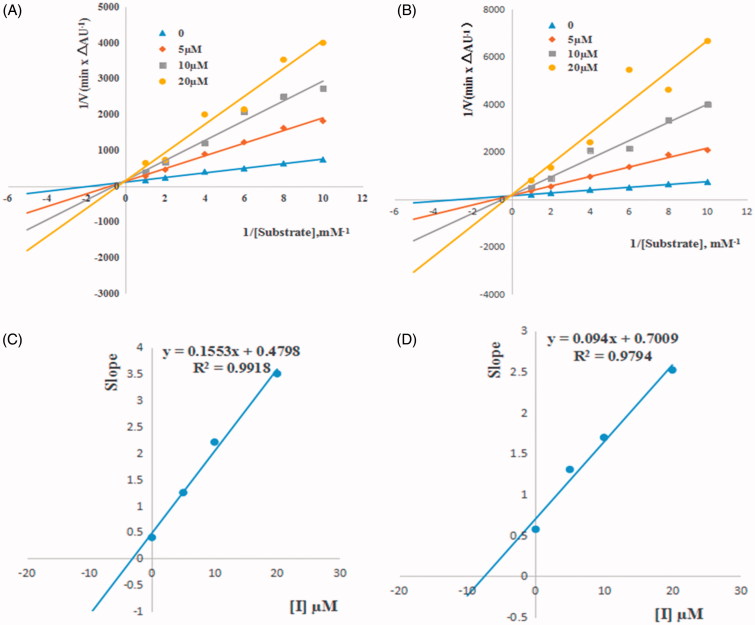
Lineweaver − Burk plots of esBChE inhibition kinetics of compounds 6a (A), 6g (B). The Lineweaver–Burk secondary plots of compounds 6a (C) and 6g (D). Reciprocals of enzyme activity (esBuChE) vs. reciprocals of substrate (butyrylthiocholine iodide) concentration in the presence of different concentrations (0−20 µM) of inhibitor. Inset: Concentrations used for inhibitor are coded with different graphic symbols.